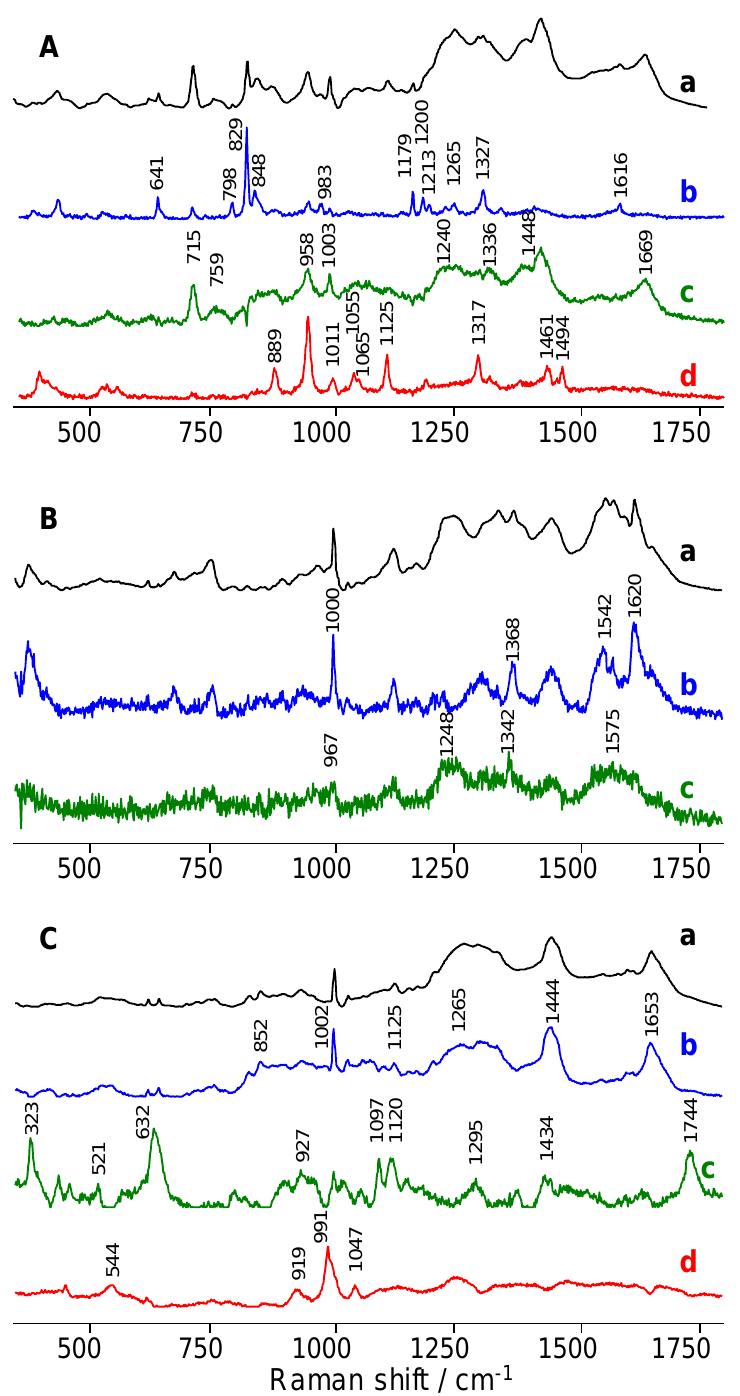
Figure 1. Multi-dimensional spectroscopic signatures of semen ( A ), blood ( B ) and saliva ( C ); average Raman spectra obtained for each body fluid (a, black lines ), and principal spectral components (b-d; blue , green and red